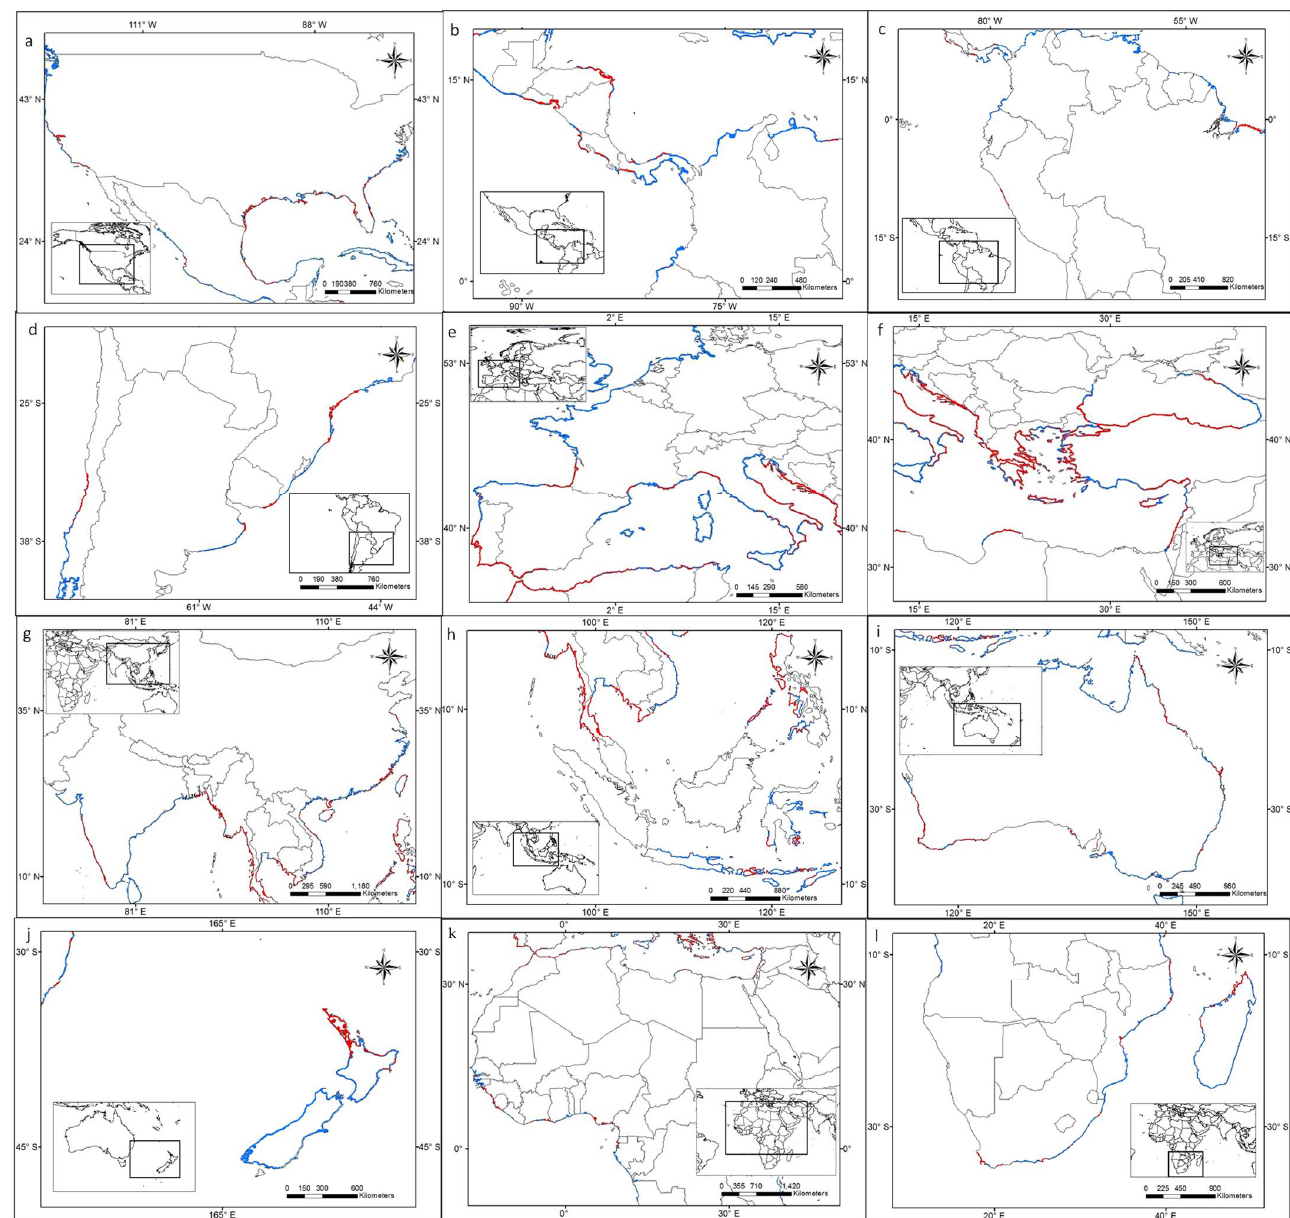
Figure 7. Species distribution modeling in the Köppen–Geiger climatic regions selected. Geographic areas of presence (red) and absence (blue) in native and non-native distribution. ( a ) North America, ( b ) Central America, ( c ), North of South America, ( d ) South of South America, ( e ) Eastern Europe, ( f ) Western Europe, ( g ) Asia, ( h ) Southeast Asian, ( i ) Autralia, ( j ) New Zealand, ( k ) North Africa, ( l ) South Africa